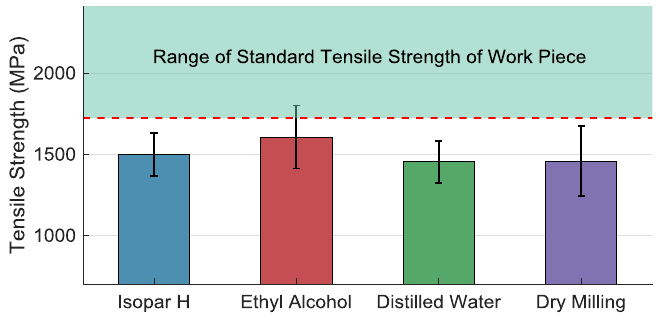
Figure 9. Tensile strength of work piece micromilled under different coolants and methods.